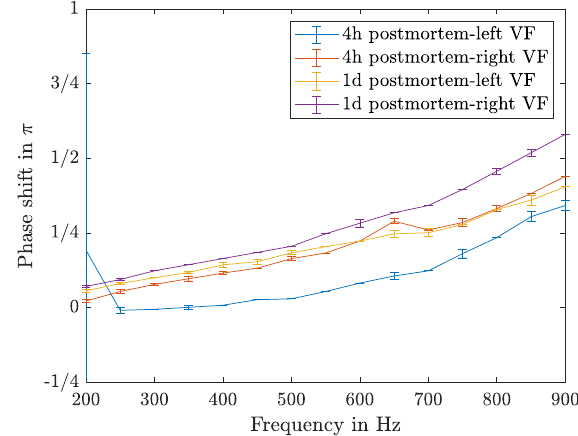
Figure 16. Phase shift of different measurements on sample K6.